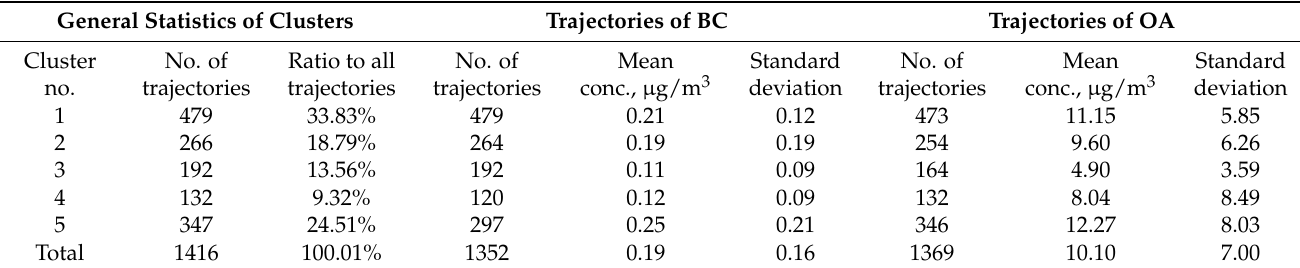
Table 2. Statistics of the